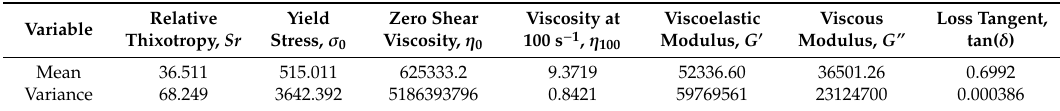
Table 2. Estimated variance of the original